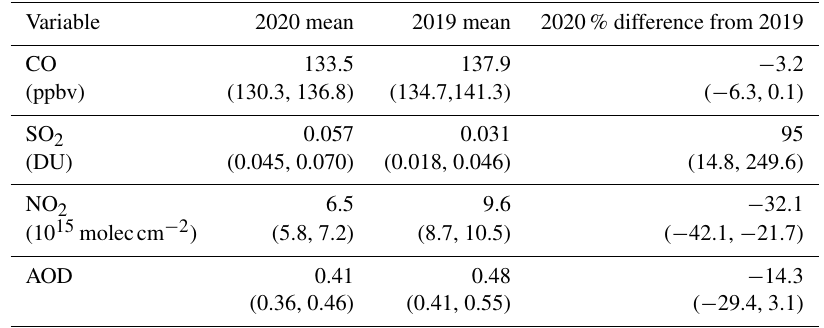
Table 1. Summary statistics for central east China comparing 2020 and 2019 during 23 January–8 April.